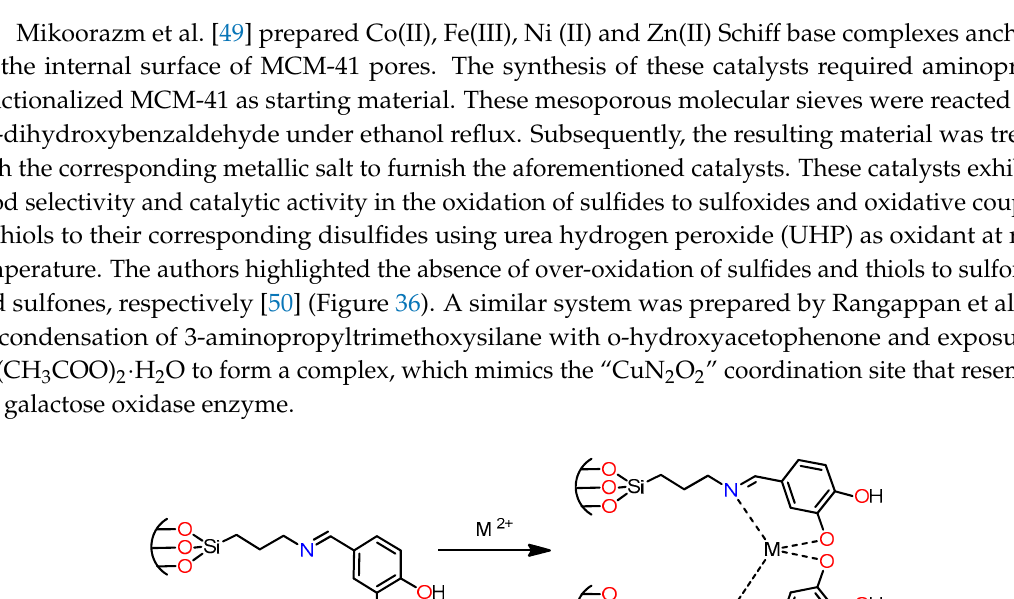
Figure 35 . Synthesis of Materials MCM-Pr, MCM-L, and MCM-C1 to MCM-C5. Reproduced with permission from [48]. Copyright 2015 American Chemical Society.